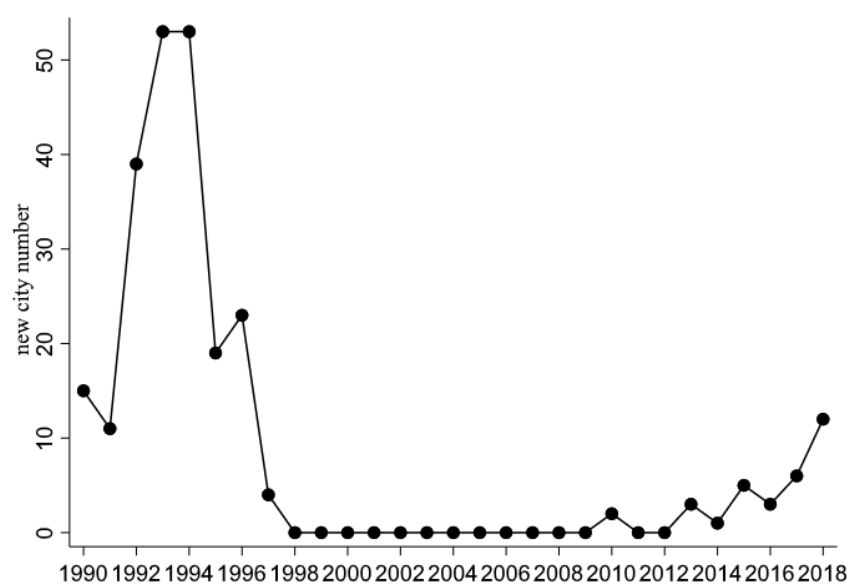
Figure 1. The number of new cities during 1990–2018. Note: From 1998 to 2009, the central government had paused applications for county-level cities. The approval procedure did not reopen until 2010. Data source: the website of the Ministry of Civil Affairs. Data source: 2014 Hangzhou Statistical Yearbook.